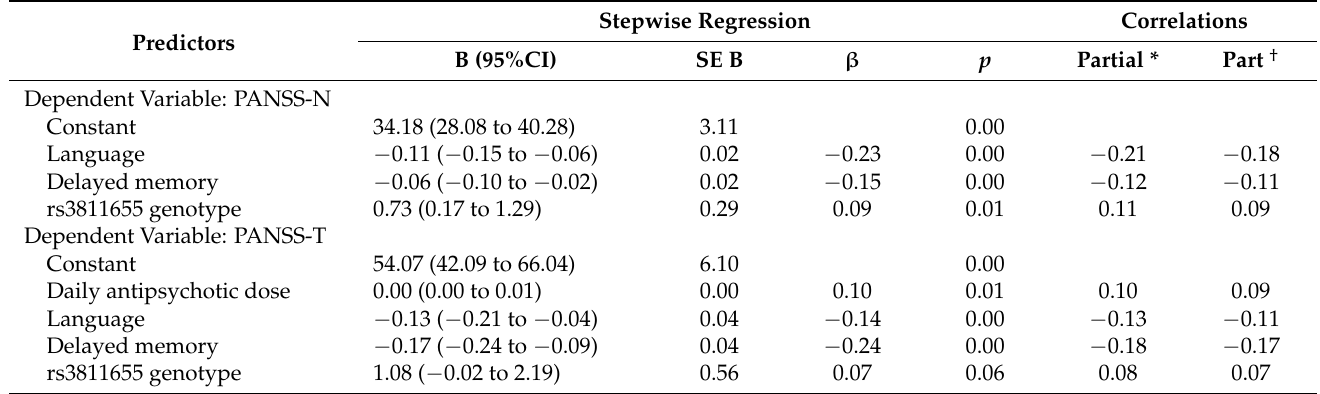
Table 3. Stepwise multiple regression analysis for related factors predicting psychiatric symptoms in patients with